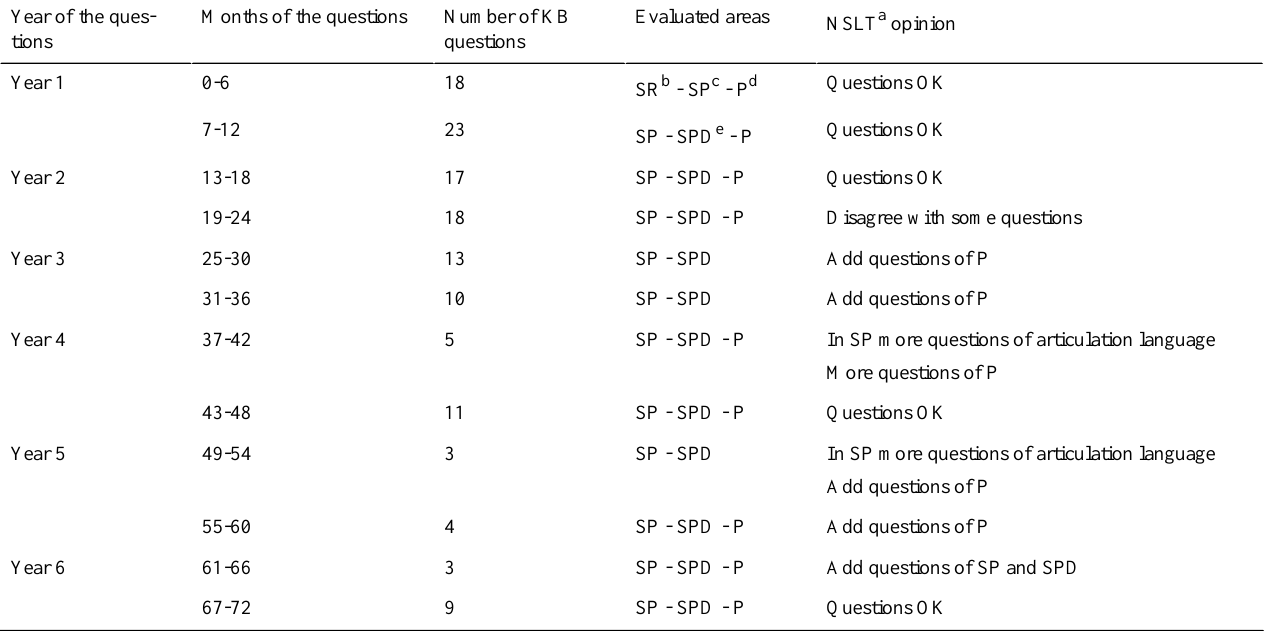
Table 4. Accuracy and refinement of the knowledge base